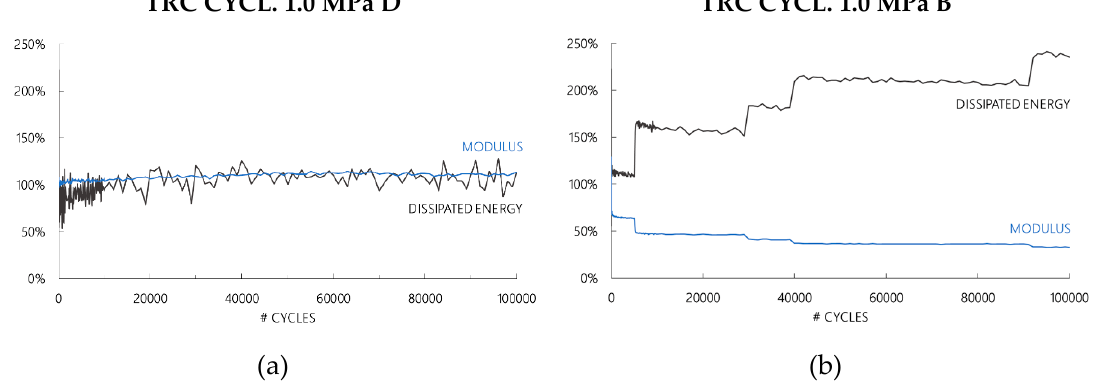
Figure 8. The evolution of the modulus and the dissipated energy of representative TRC coupons during the loading–unloading cycles: ( a ) an uncracked sample and ( b ) a cracked sample.